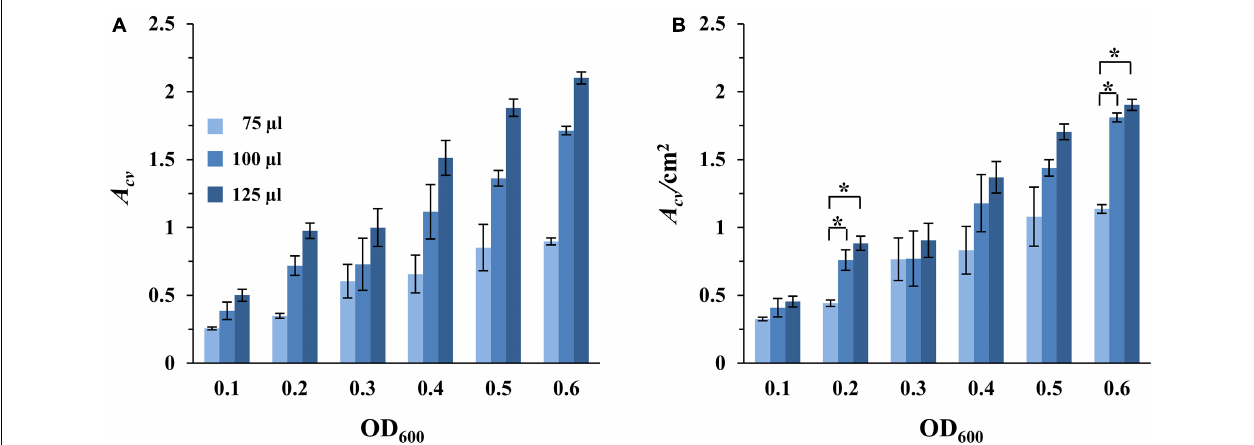
FIGURE 3 | SBF formation with aeration. Experiments were conducted with DK1622 (WT) similarly as in Figure 2 , except that the microplates were incubated with rotatory shaking instead of under static conditions. The amounts of SBFs were represented either by A cv (A) or by A cv /cm 2 (B) . Asterisks represent the initial OD 600 values that result in statistically significant differences in normalized SBF formation between the 75 µ l samples and both the 100 and 125 µ l samples. Significance was determined by Student’s t -test, * P <